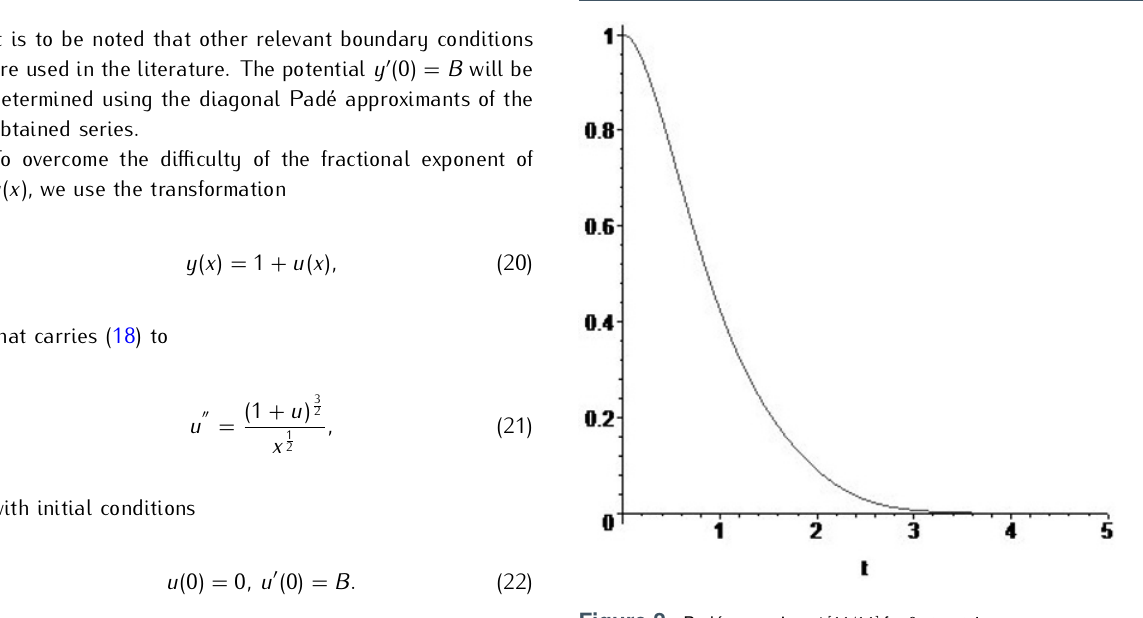
[11 / 11] for 0 ≤ t ≤ 4 .